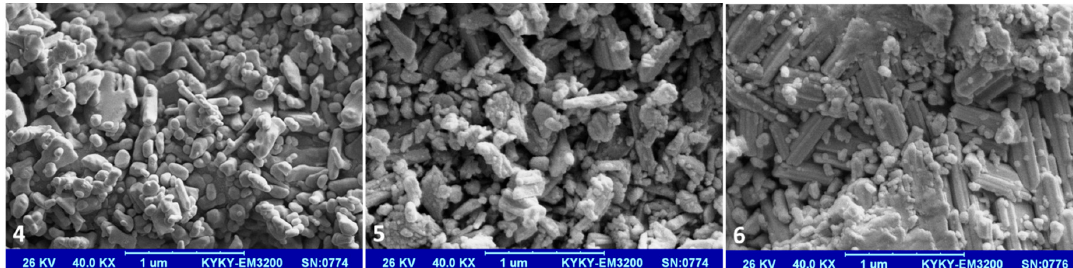
Figure 2. The micrographs of phosphate polymers 4 – 6 (1 µm width).